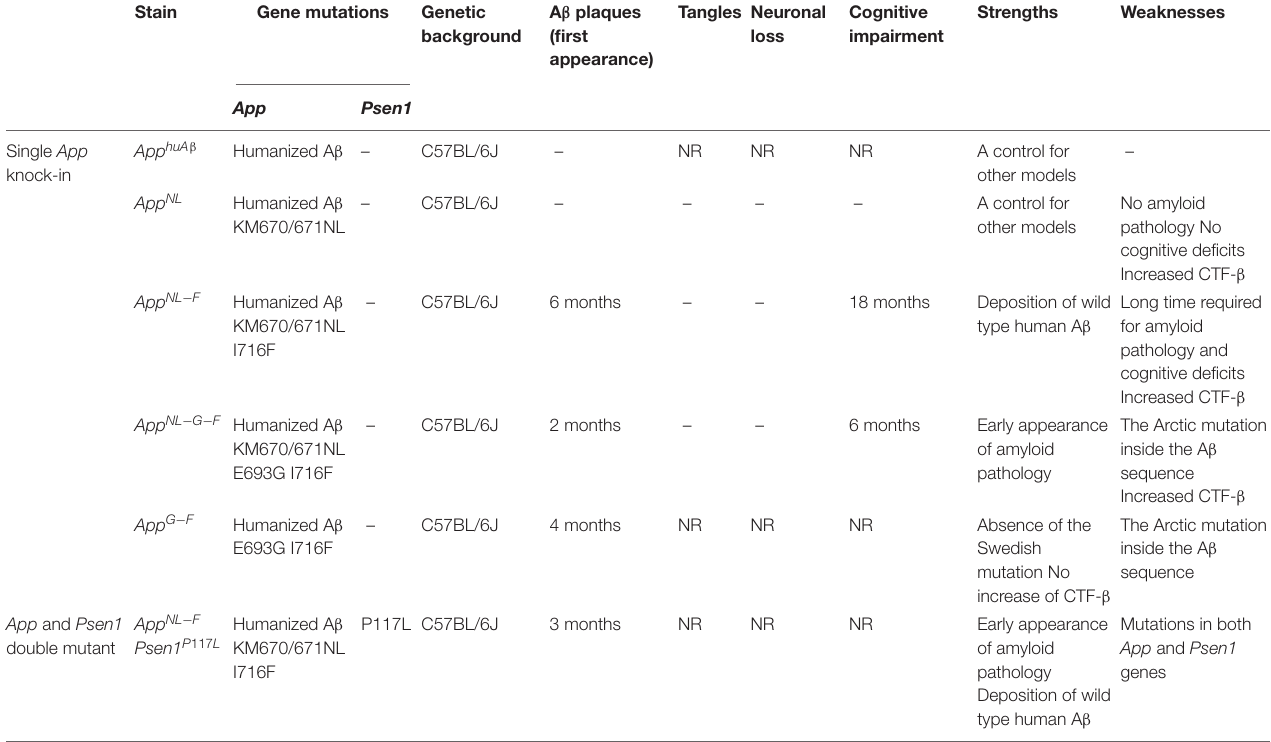
TABLE 3 | Characteristics of the App knock-in mouse